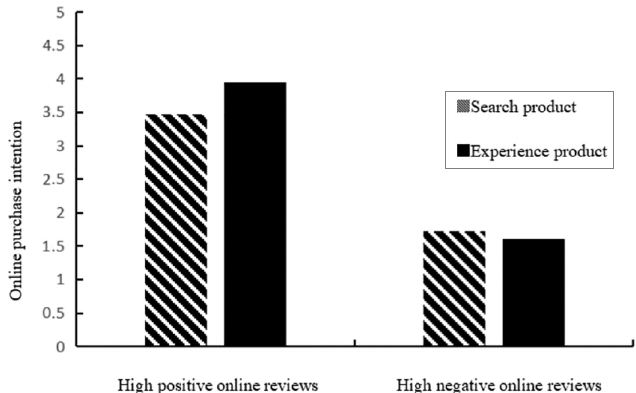
Table II. Analysis of variance of online reviews x commodity types on purchase intention